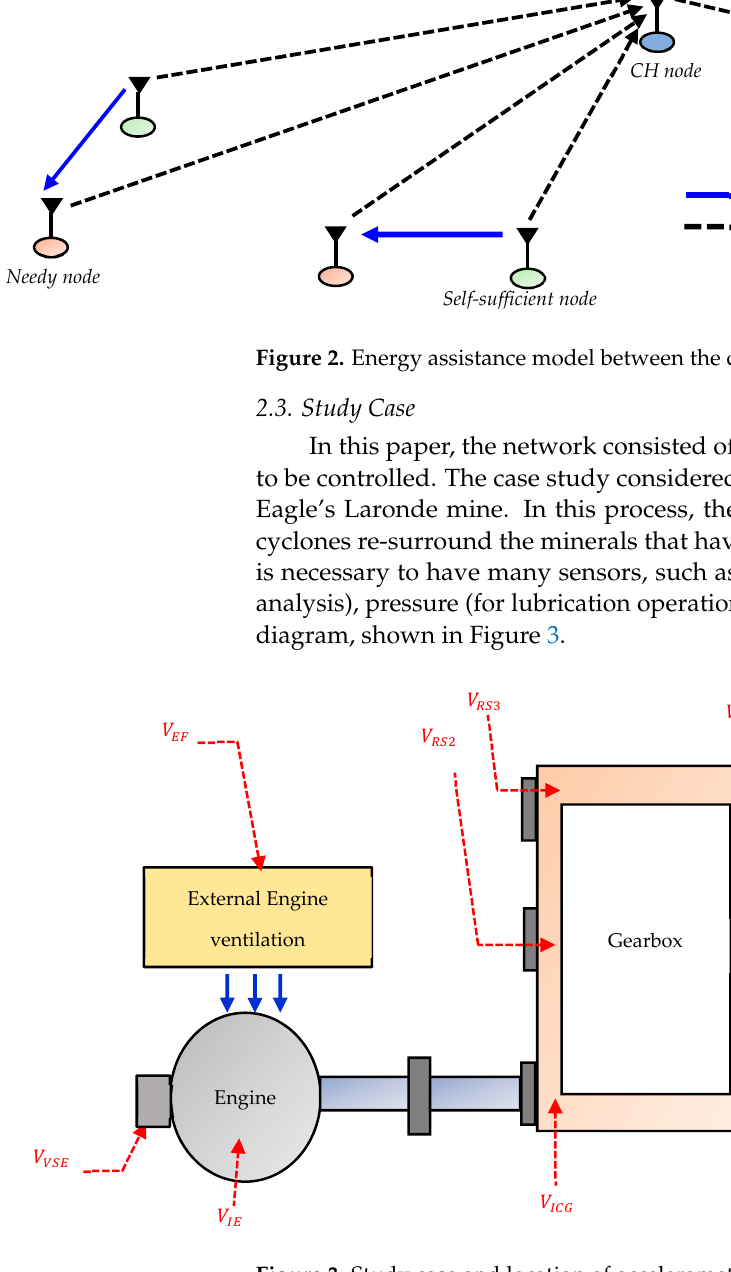
Figure 3. Study case and location of accelerometers on the SAG drive diagram.